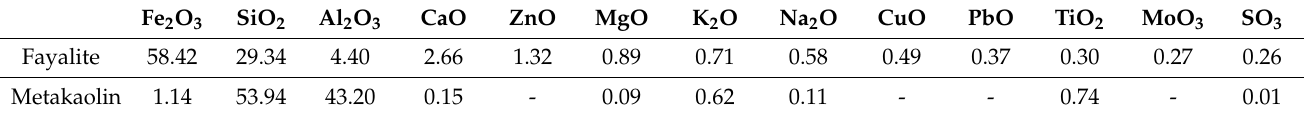
Table 1. Chemical composition of the geopolymer precursors, determined by XRF, (%).